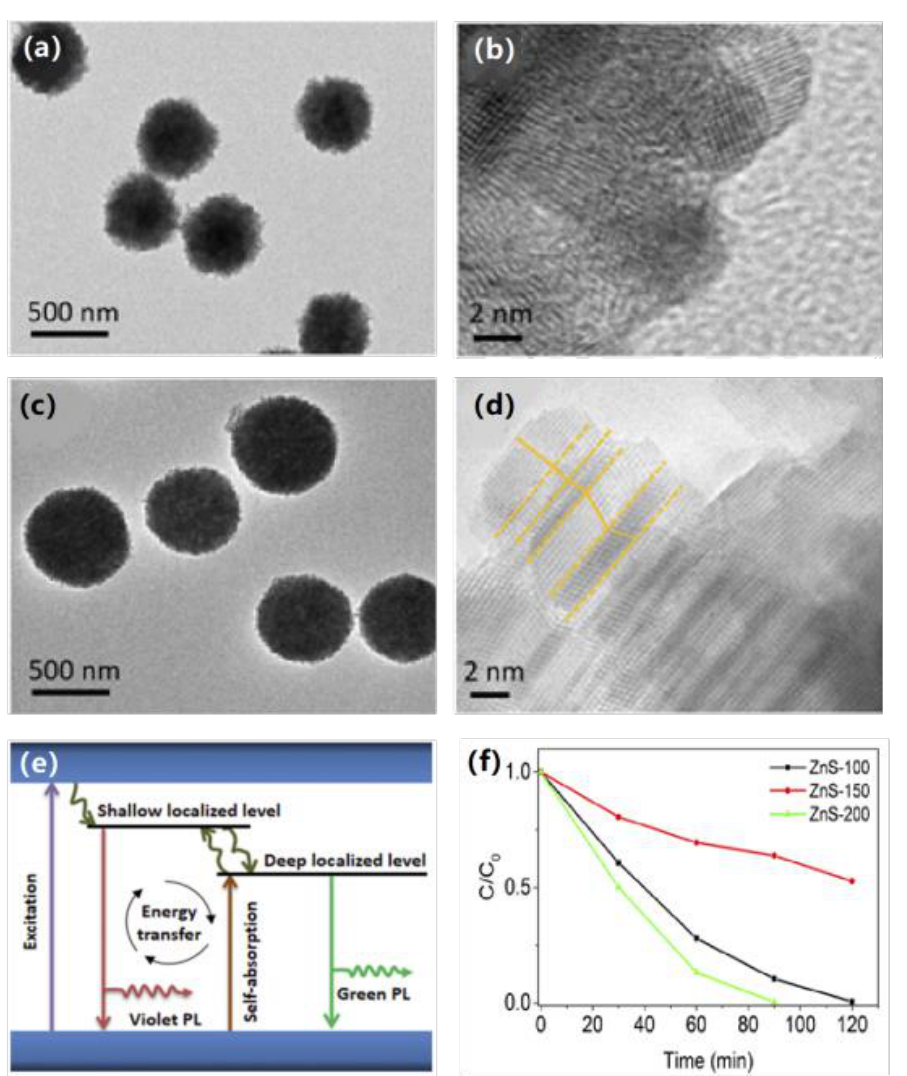
Figure 8. ( a ) TEM and ( b ) HRTEM images of ZnS-100. ( c ) TEM and ( d ) HRTEM images of ZnS-150. ( e ) Schematic illustration of electron transfer and proposed mechanism for photocatalytic performance. ( f ) Photocatalytic performances of samples for degradation of MB under xenon lamp irradiation. Copyright © 2020 Clarivate.